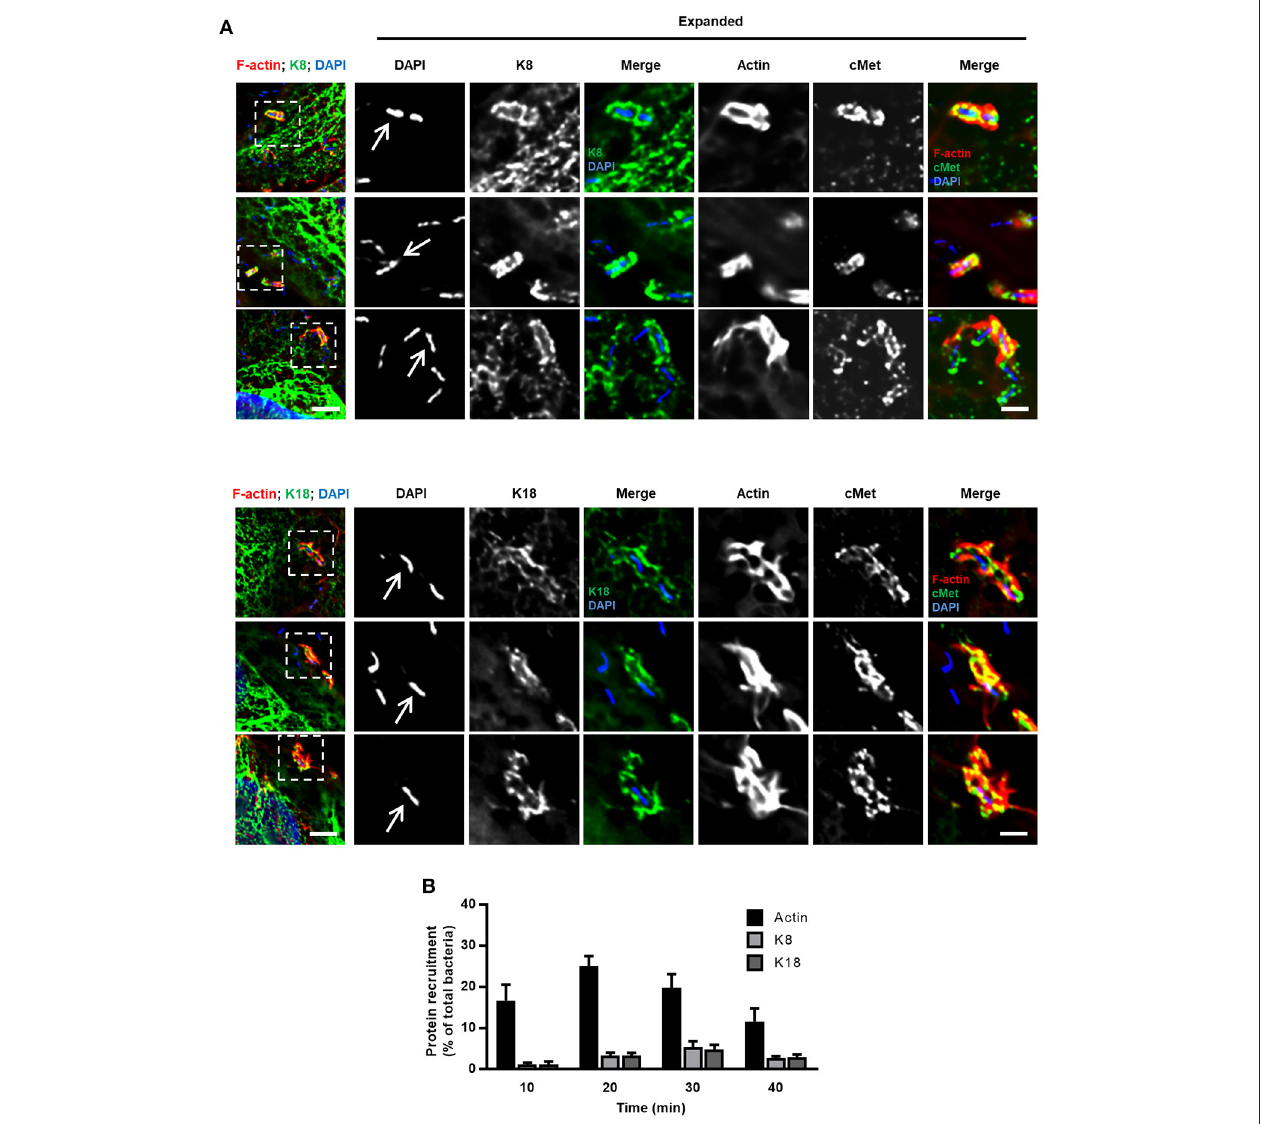
FIGURE 2 | K8 and K18 are recruited at the bacterial entry site during InlB-mediated cellular invasion. (A) Representative widefield microscopy stack projections of HeLa cells incubated with L. innocua InlB for 5min, fixed and immunostained for cMet (green) and for K8 (upper panels, green) or K18 (lower panels, green). F-actin was stained with phalloidin (red), DNA with DAPI (blue). Scale bar, 5 µ m. Arrows indicate bacteria that display accumulation of K8, K18, cMet, and F-actin at their vicinity. Insets show high-magnification images. Scale bar, 2 µ m. (B) Quantification of K8, K18, and actin recruitments to the entry site of L. innocua InlB. Results are expressed as the percentage of total number of bacteria associated to cells. Values are the mean ± S.E. of at least three independent experiments.